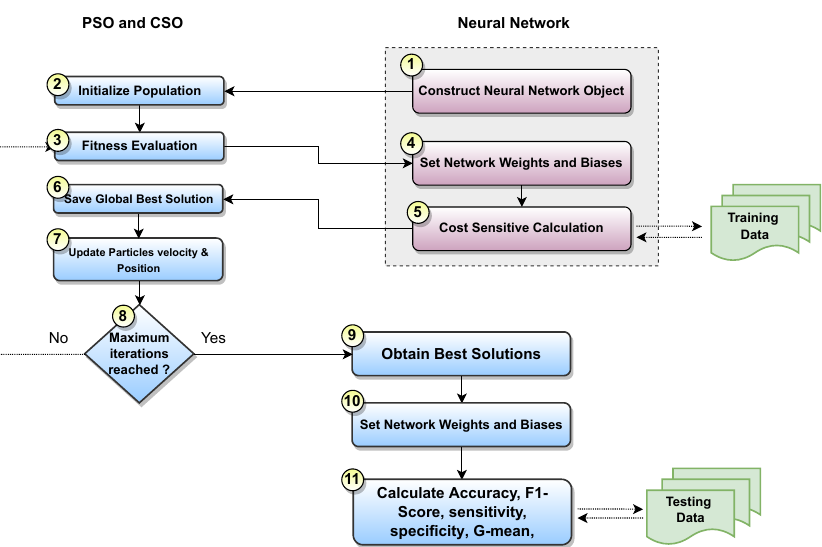
Figure 1. The cost sensitivity fitness function that was embedded in the metaheuristic optimization- based neural network architecture. Here, the metaheuristic optimizer (PSO or CSO) generated the NN weights and biases. After the optimizer found a solution, the solution was used to set the weights and biases for the NN and then the constructed NN was used to generate the predictions. After that, the costs were calculated by the cost sensitivity fitness function and the best solution was saved. These steps were repeated up to the maximum number of iterations and then the saved best solution was used to set up the NN weights and biases. Then, the trained NN was used to classify the instances in the testing dataset and all of the evaluation metrics were calculated and reported.